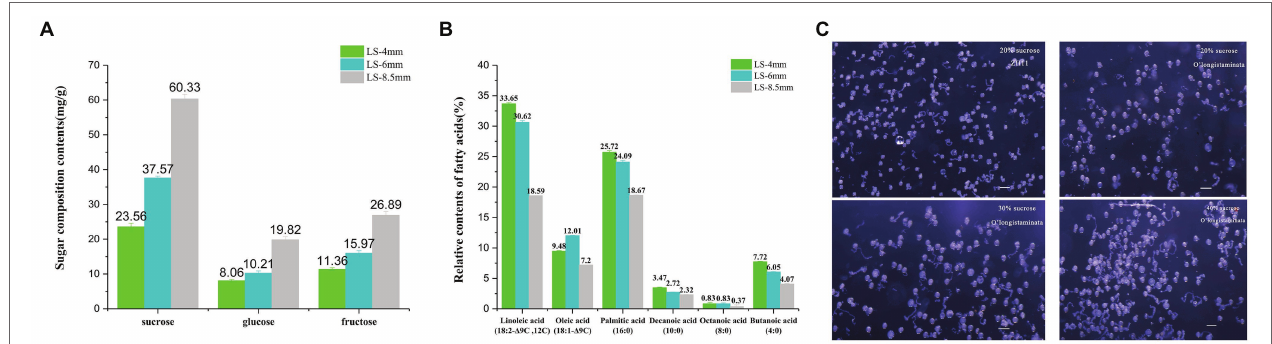
FIGURE 3 | Metabolite analysis of pollen development and an in vitro pollen germination assay in O. longistaminata . (A) Concentrations of three sugar components in pollen from 4-, 6-, and 8.5-mm spikelets. (B) Relative contents of different fatty acids in pollen from 4-, 6-, and 8.5-mm spikelets. (C) Pollen germination rate at different sucrose concentrations in O. longistaminata and O. sativa . The sugar composition tests were performed with three replicates, each consisting of 0.1 g anther sample. The relative content of fatty acids tests were performed with three replicates, each consisting of 0.25 g anther sample. Values are mean ± standard error. Data followed by different lower-case letters denote significant differences between sugar composition/relative content of fatty acids at the 5% level according to least significant difference test (LSD)